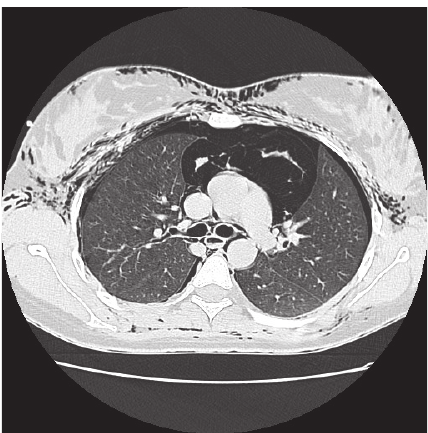
Figure 1: Thoracic computed tomography showing pneumomedi- astinum, subcutaneous emphysema, and minimal pneumothorax.